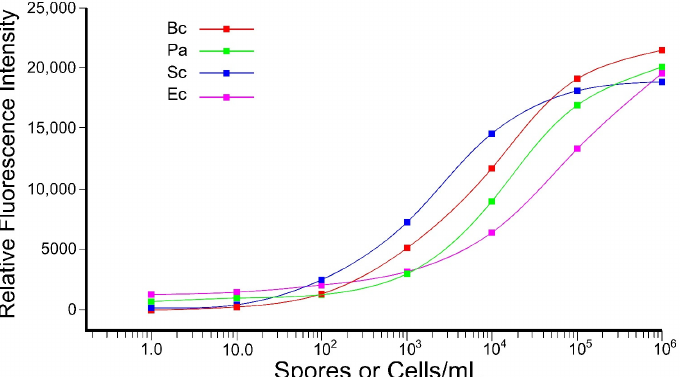
Figure 8. Multi-analyte detection using xMAP system. Antibody-based detection of B. cereus (Bc; rAb4) spore lysate along with P. aeruginosa (Pa; mAb5), S. cerevisiae (Sc; mAb6), and E. coli (Ec; mAb7) cell lysates in the presence of other microorganisms as a microbial mixture. This experiment was performed in triplicate, and no significant difference was observed.